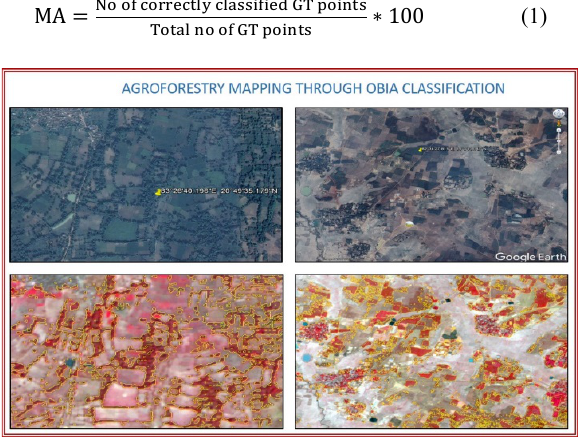
Figure 4. Delineation of Linear, Single and Block